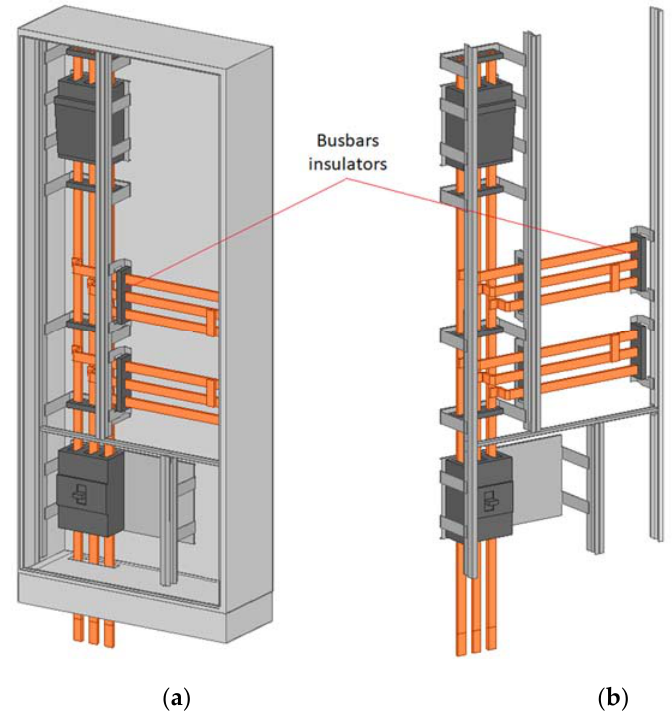
Figure 4. Views of the finished construction 3D model of the switchgear: ( a ) open; ( b ) the internal part of the switchgear.